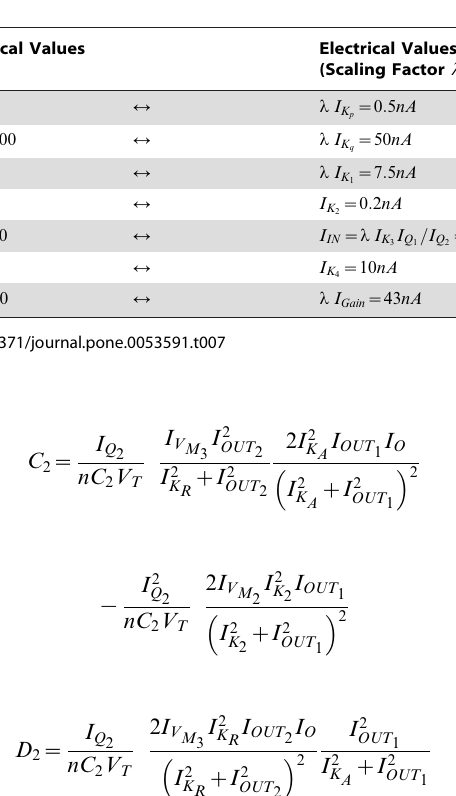
Biological Values Electrical Values